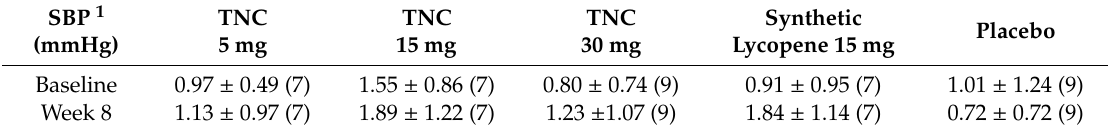
Figure 2. Changes in SBP values during the single-blind 16-week study extension. SBP values are the mean for the 27 subjects who completed this phase. * p < 0.05; ** p < 0.01 for changes to baseline within treatment arm. Table 6. Plasma lycopene value at baseline and at eight weeks of treatment.